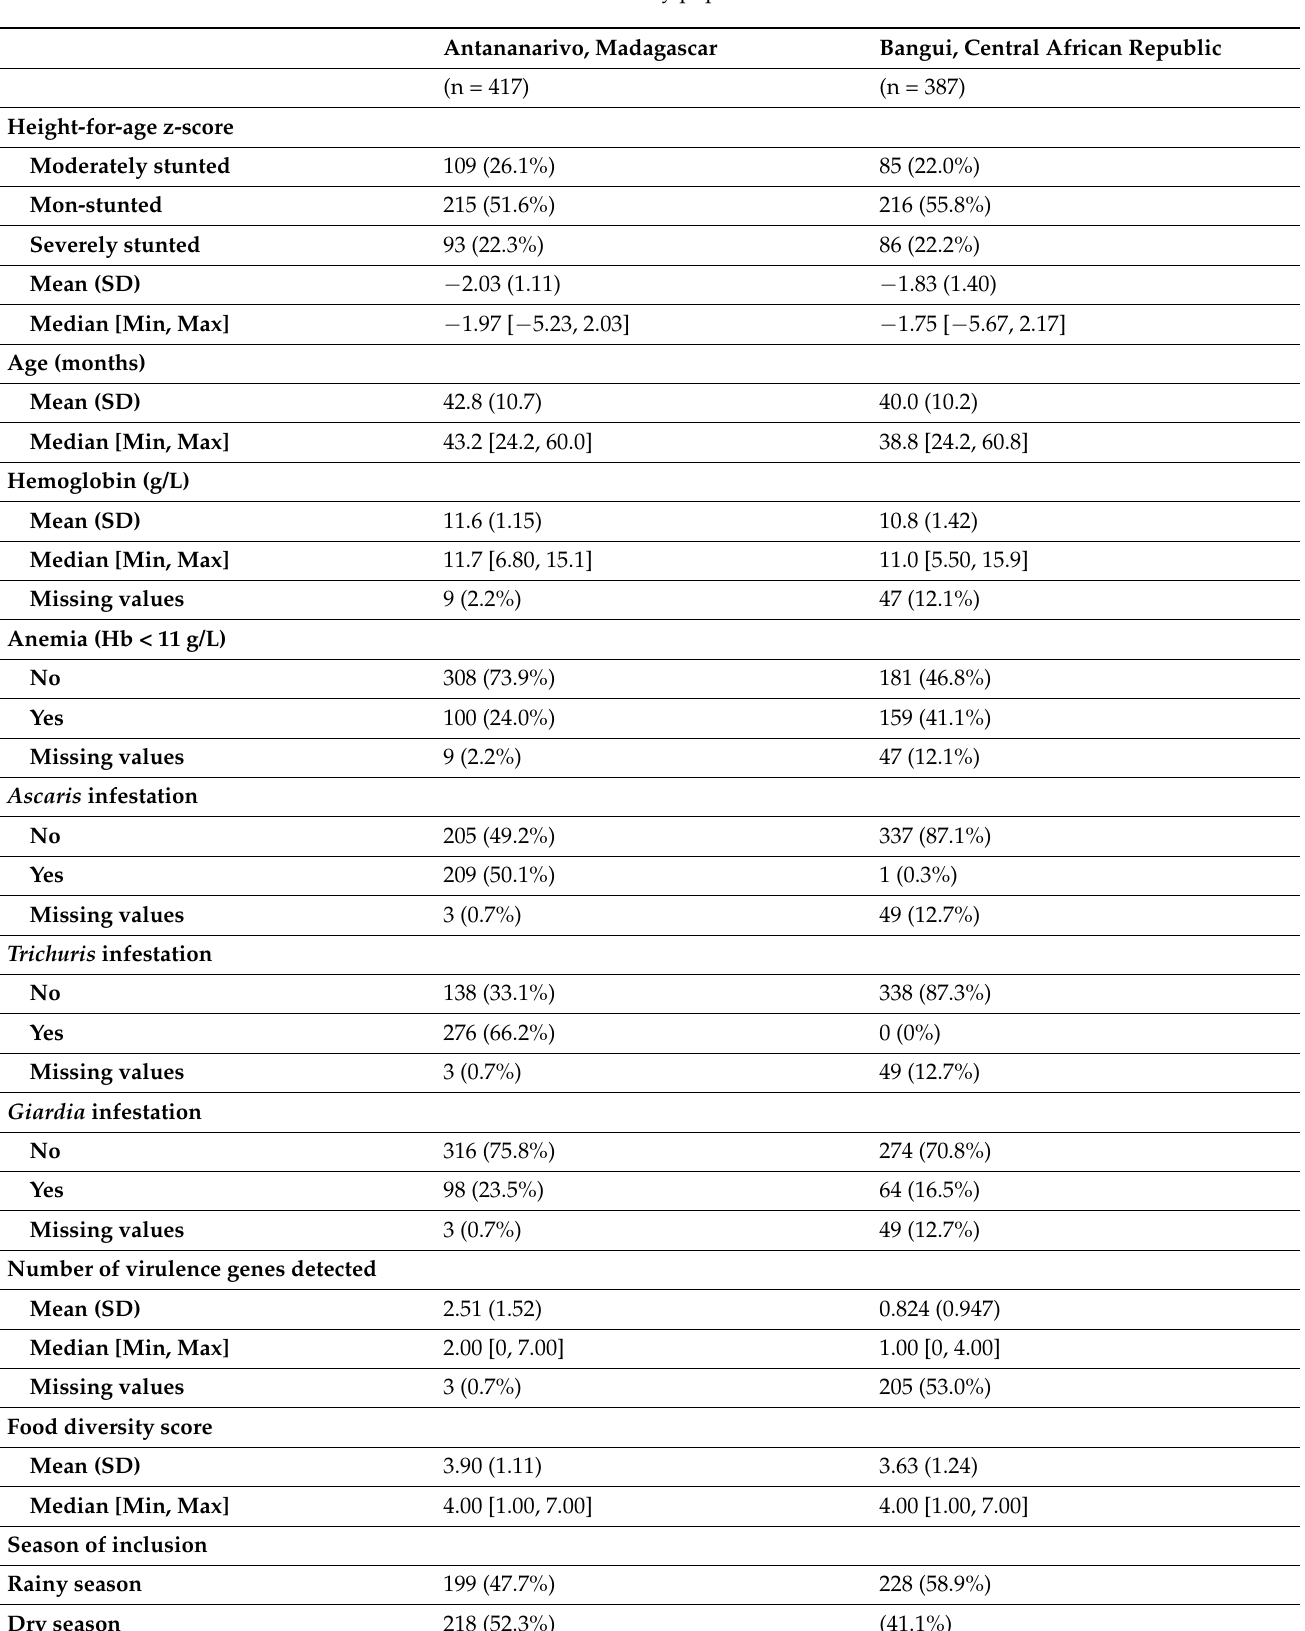
Table 1. Characteristics of the study